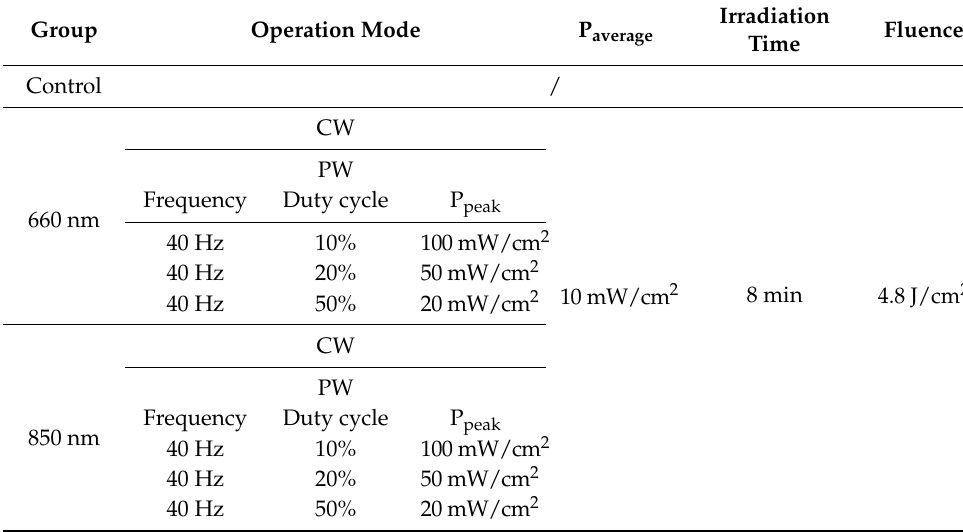
Table 4. Experimental conditions for duty